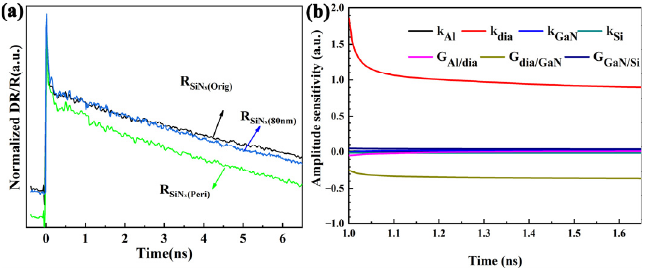
Figure 2. ( a ) Normalized heat reflection signal as a function of time, ( b )sensitivity analysis of various parameters of TDTR for GaN ‐ SiN x ‐ diamond.